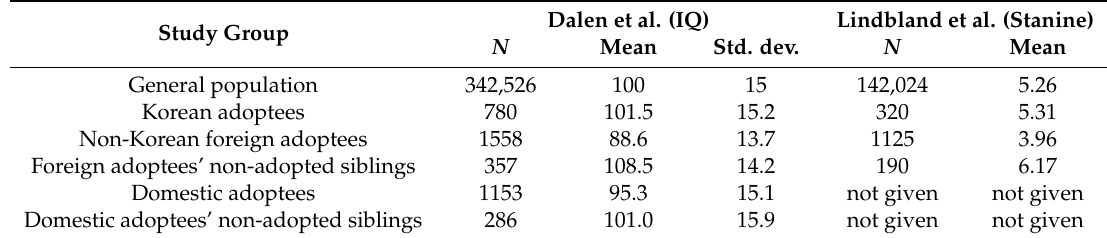
Table 3. Cognitive-test scores of Swedish men, adopted and non-adopted. Study